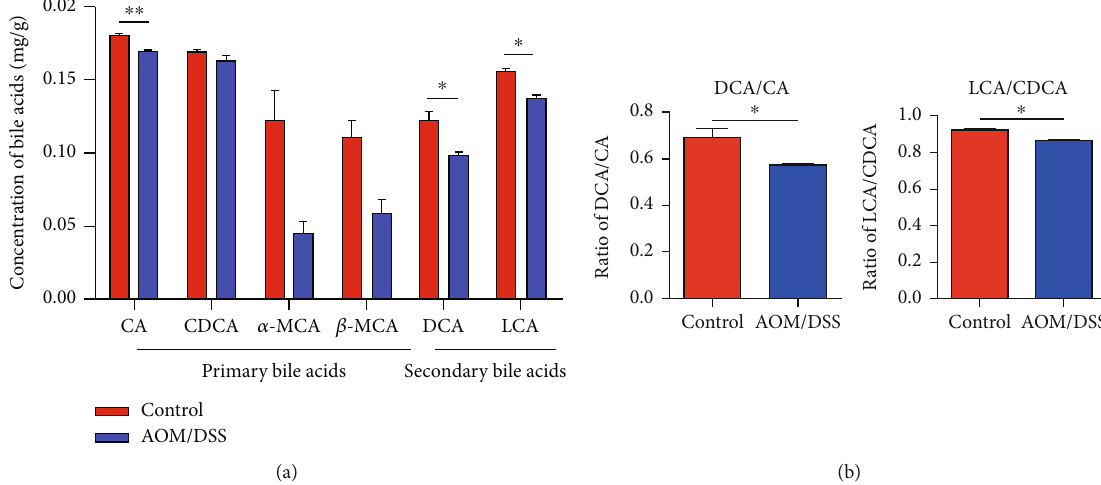
Figure 5: The bile acid pro fi le alteration in feces after AOM/DSS treatment. (a) Levels of fecal bile acids including CA, DCA, and LCA were reduced in the AOM/DSS group. (b) The conversion of primary bile acids to secondary bile acids was reduced in the AOM/DSS group, as evidenced by a decreased ratio of DCA/CA and LCA/CDCA. ∗ p < 0 : 05 , ∗∗ p < 0 : 01 . n = 5 in each group.